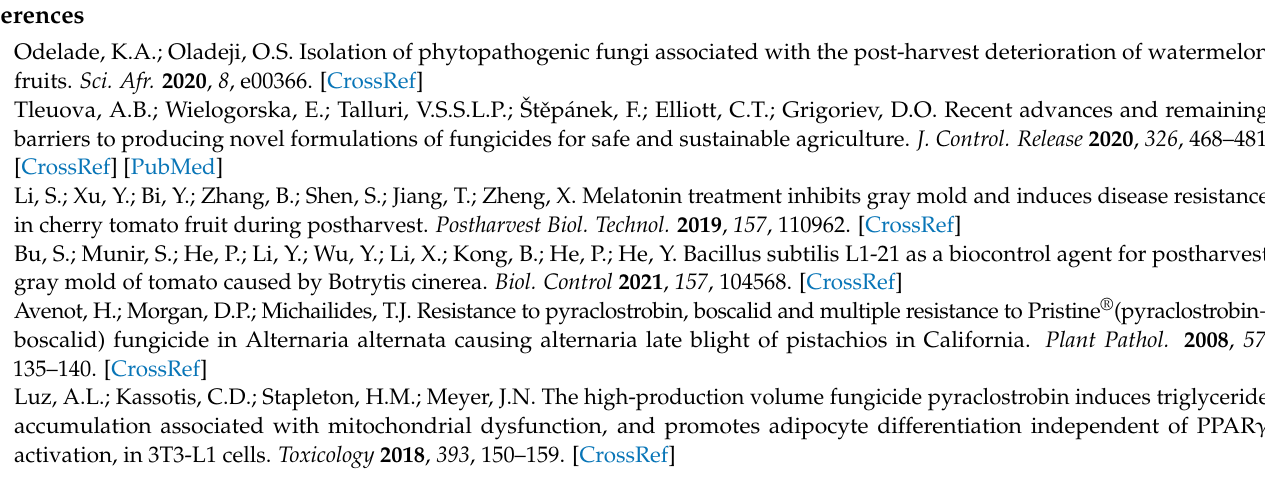
Table S2: Calibration curves and matrix effects of pesticides; Table S3: Quality control (QC) of real sample detection; Table S4: Terminal residues of boscalid and pyraclostrobin in watermelon samples; Figure S1: LOQ determination of boscalid and pyraclostrobin; Figure S2: Mass spectra of boscalid and pyraclostrobin in MRM